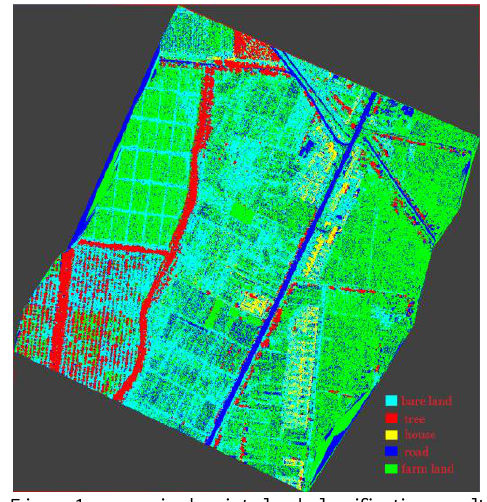
Figure 1: supervised point cloud classification result